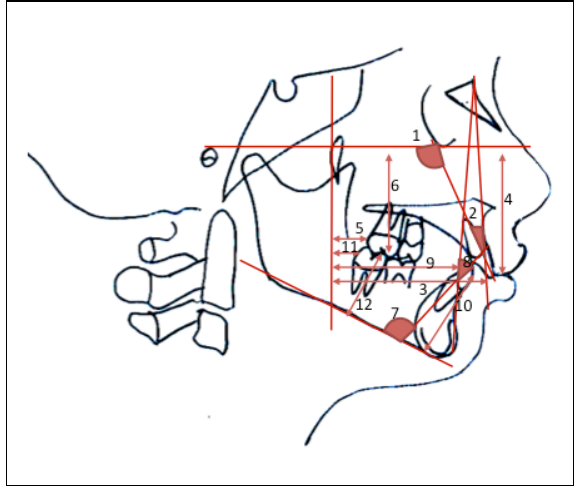
Figure 2. Dental cephalometric measurements. 1.U1-FH(°): angle between the axis of the upper incisor and FH line; 2.U1-NA(°): angle between the axis of the upper incior and NA line; 3.U1-PTV (mm): the distance between the tip of the upper incisor and PTV; 4.U1-FH (mm): the distance between the tip of the upper incisor and FH plane; 5.U6-PTV (mm): the distance between the most distal point of the distal contour of the upper molar and PTV; 6.U6-FH (mm): the distance between the tip of the mesiobuccal cusp of the upper molar and FH plane; 7.IMPA(°): angle between the axis of the lower incisor and the mandibular plane angle; 8.L1-NB(°): angle between the axis of the lower incisor and NB line; 9.L1-PTV (mm): the distance between the tip of the lower incisor and PTV; 10.L1-MP (mm): the distance between the tip of the lower incisor and mandibular plane; 11.L6-PTV (mm): the distance between the most distal point of the distal contour of the lower molar and PTV; 12.L6-MP (mm): the distance between the tip of the mesiobuccal cusp of the lower molar and mandibular plane.